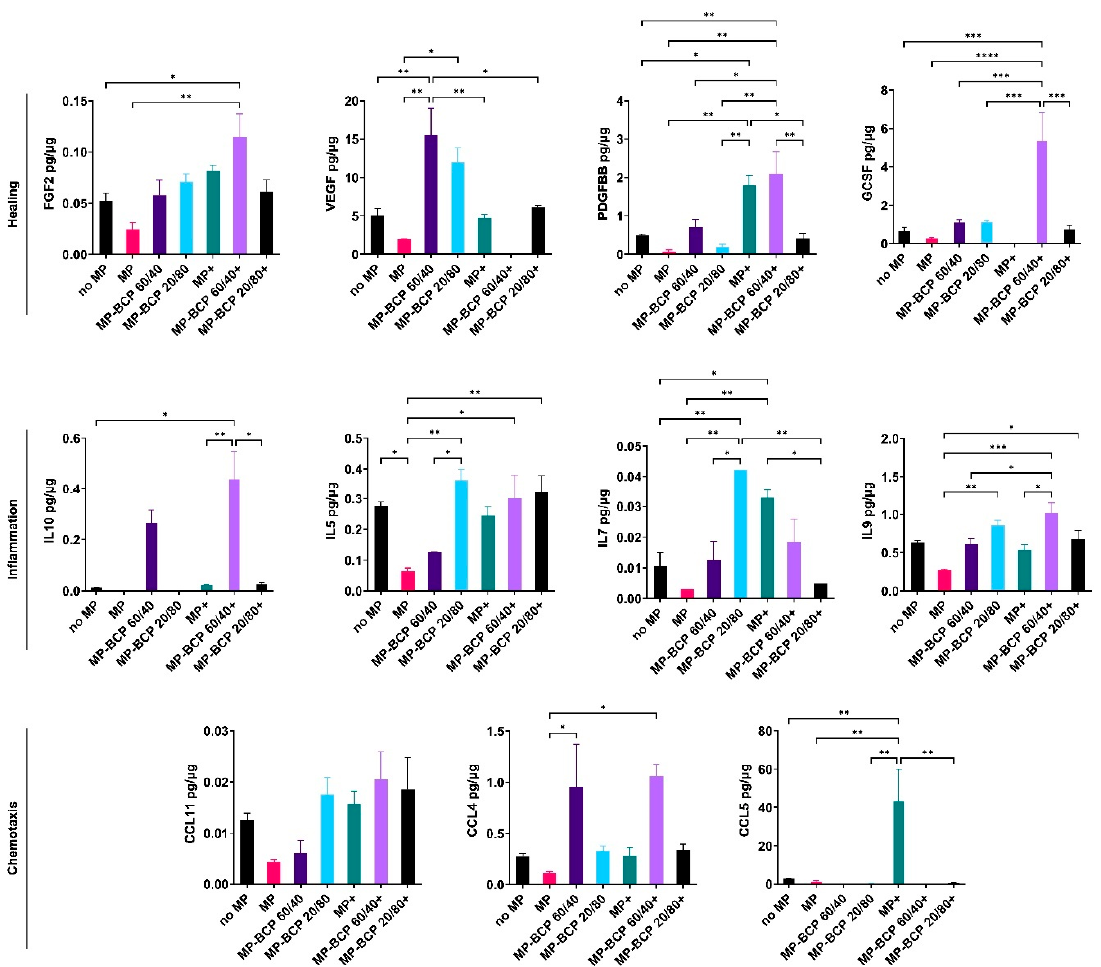
Figure 7. Multiplex cytokine assay of MPs co-cultured with MSCs and BCP granules (BCP 60/40 or BCP 20/80). Cytokines related to healing, inflammation and chemotaxis were measured after 72 h. + indicates cytokine stimulation. Concentration of each analyte (pg/mL) was normalized to total protein concentration of the conditioned media (µg/mL). Statistical analyses are based on one-way ANOVA with Tukey’s multiple comparison tests; * p < 0.05; ** p < 0.001; *** p = 0.0001; **** p < 0.0001.